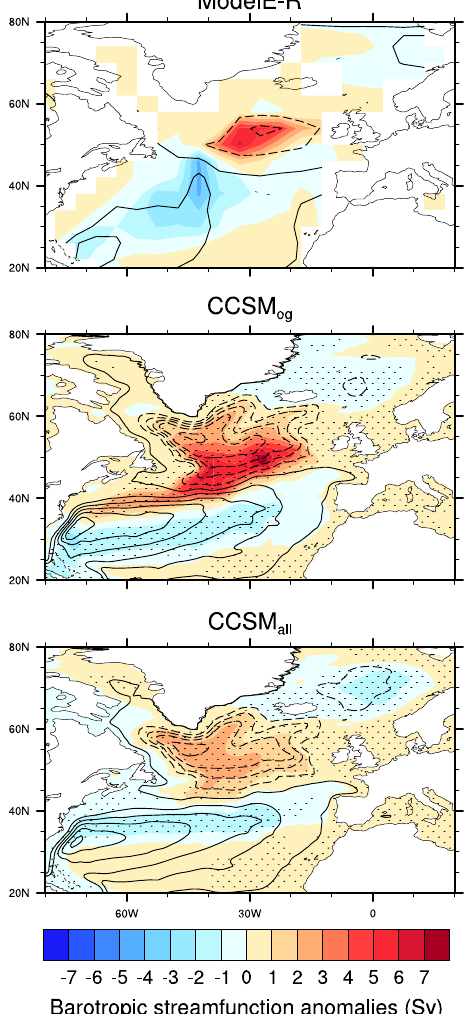
Fig. 6. Control values for barotropic streamfunction (contour lines) and streamfunction anomalies in the first fifty years following the MWP relative to the control simulation, in Sv (colored contours). The contour interval for the control values is 10Sv. Dashed lines show negative streamfunction values, or a cyclonic circulation. Pos- itive (negative) anomalies for a cyclonic (anticyclonic) circulation indicate weakening of the transport. Stippling shows statistical sig- nificance for anomalies at the 95% level according to a Student’s t test. Statistical tests were not performed for ModelE-R since only decadal averages were